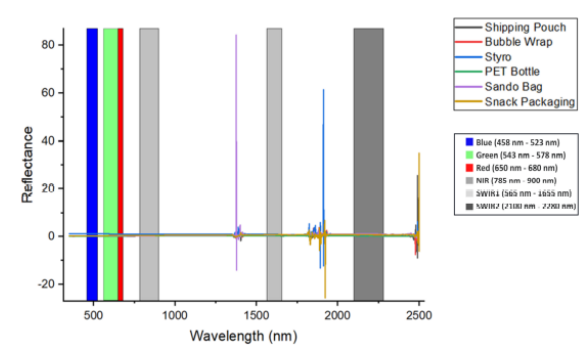
Figure 3 . Decision tree for selecting training data for the Water